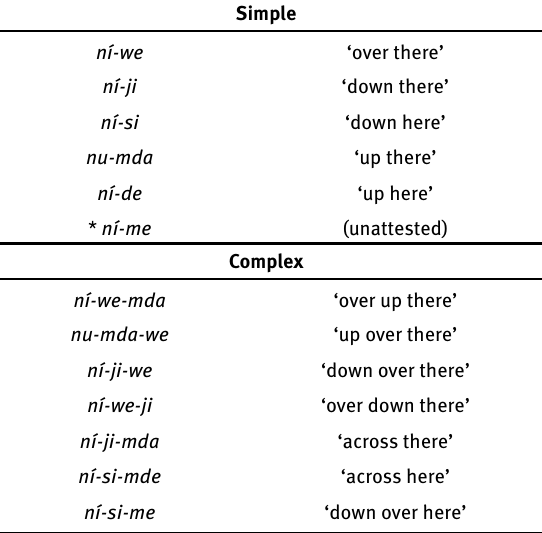
Table 2. Kula derived deverbal